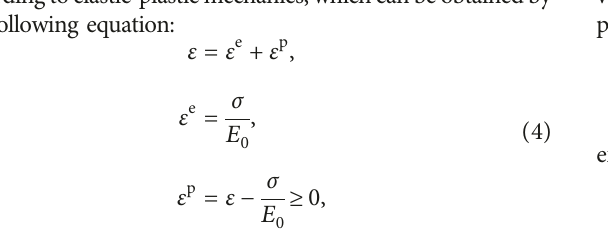
� 1.55g/cm 3 ; (b) ρ � 1.65g/cm 3 d d